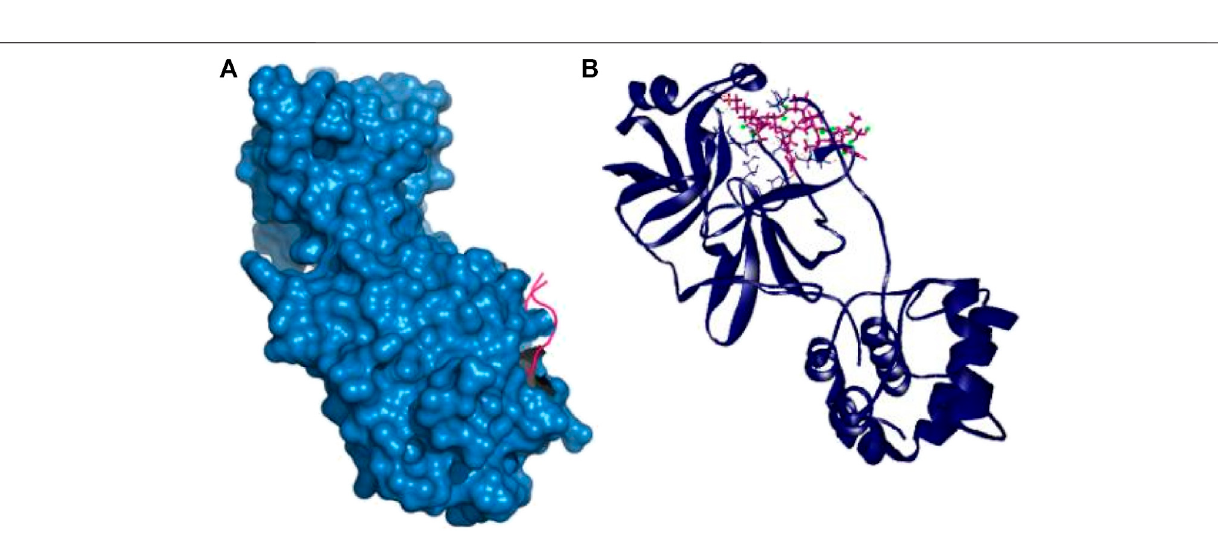
FIGURE 2 | Nonbonded interaction with the main protease and P39 peptide (A , B)